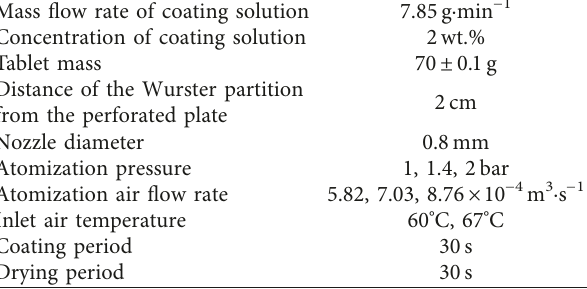
Figure 2: Schematic of the external mixing two-fluid Table 4: Process conditions during coating in fluid bed.